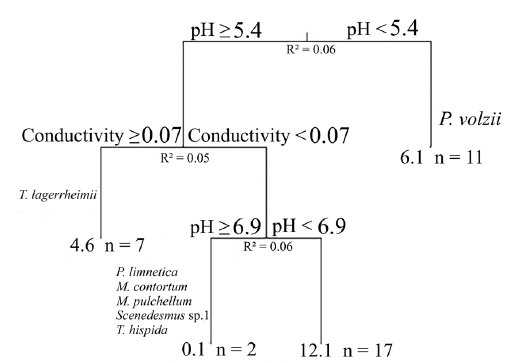
Figure 3. MRT analysis of the interaction between species density and local predictors of the 37 water reservoirs sampled during the dry season (R 2 = 0.17). n is the number of sample units; the number on the left is the sum of the squares of the errors in each group. The species presented in each group are the most important for the explanation of each group. The measurement unit of conductivity is mS.cm -1 . Error = 0.8 CV Error = 1.2 SE = 0.05. Data used from Silva et al. (2022).